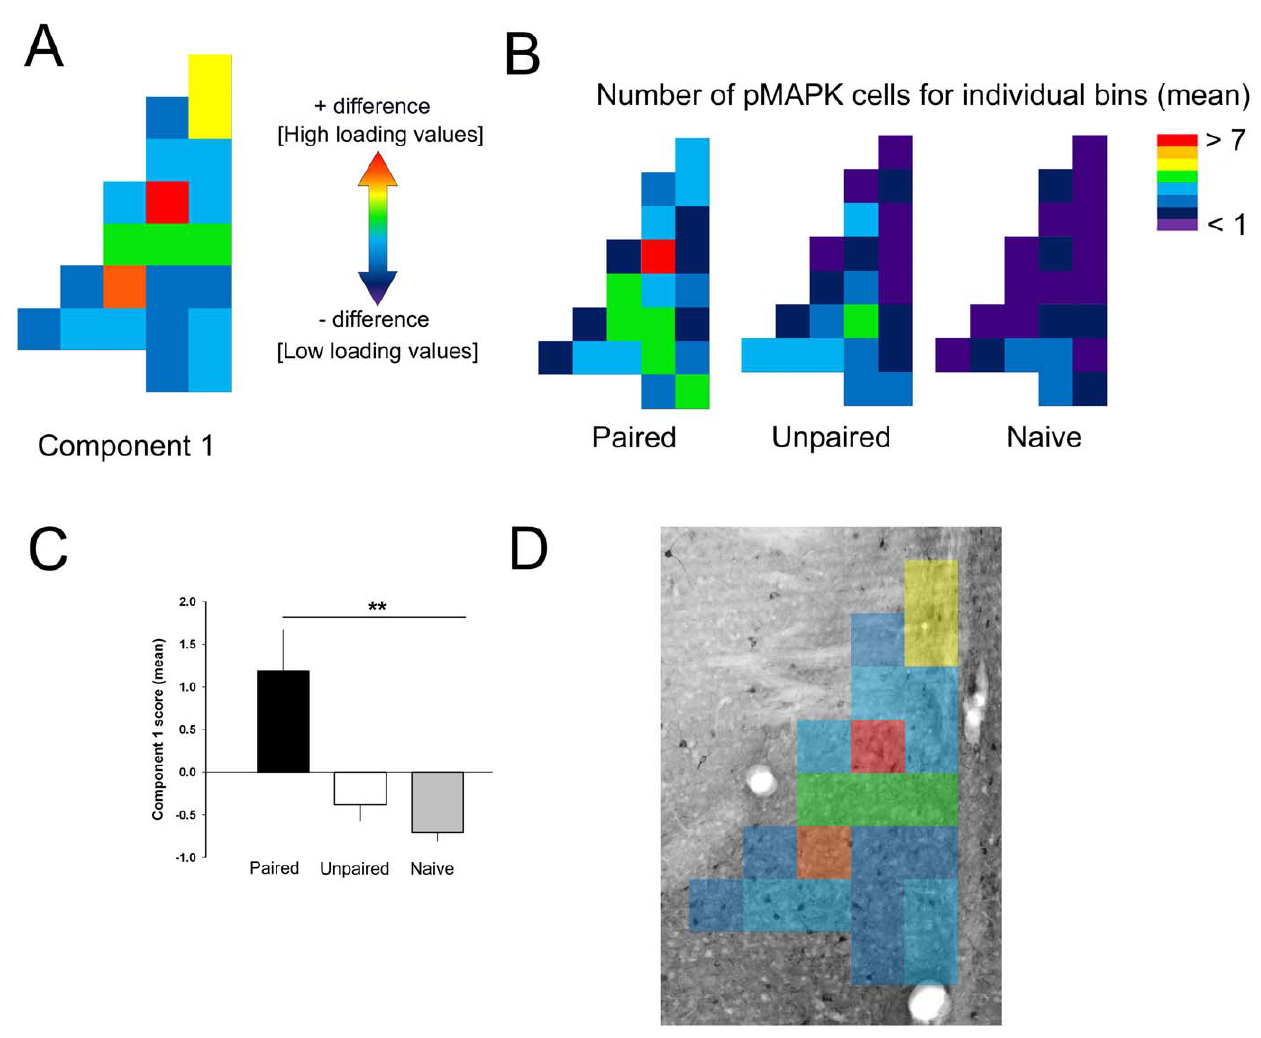
Figure 4. Spatial principal component analysis revealed a pattern of pMAPK activated neurons unique to auditory fear conditioning. (A) Component 1 loading map best represents the difference in pMAPK activity between groups. The loading values can be interpreted as representing regions of difference in pMAPK activity between the experimental conditions as depicted in panel B. (B) Grid maps depicting the mean value of pMAPK activity for each experimental condition. The mean values for pMAPK activated cells were assigned a color value from violet (low cell number) to red (high cell number) (C) The bar graph reflects the mean difference in the component 1 scores between Paired, Unpaired and Naive groups (one-way ANOVA; Bonferroni post-hoc). (D) Photomicrograph (4 x magnification) of the LAd with superimposed component 1 loading values. ** denotes p , 0.01.